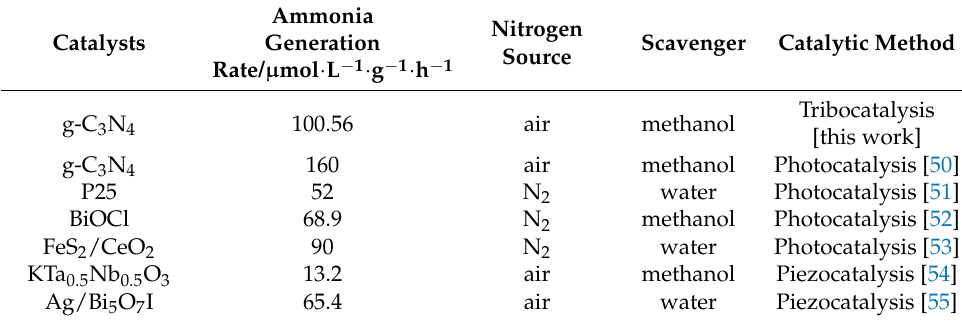
Table 1. Summary of ammonia fixation performance of different catalysts and different catalytic methods.